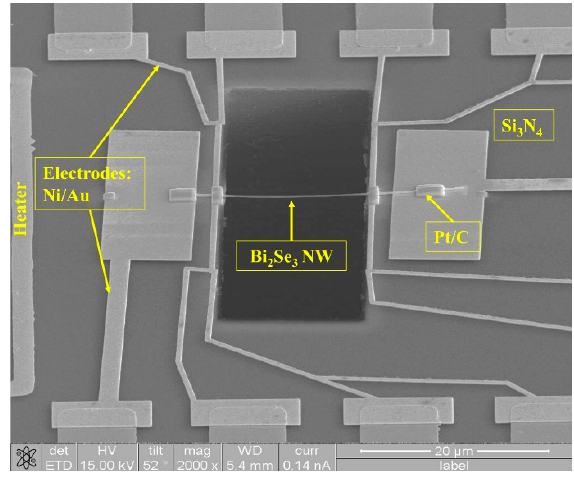
Figure 2. SEM images of a single-crystal Bi 2 Se 3 NW (diameter = 200 nm) placed on a Si 3 N 4 micro- Figure 2. The SEM image of a single-crystal Bi 2 Se 3 NW (diameter = 200 nm) placed on a Si 3 N 4 chip following electrode formation by using a FIB. microchip following electrode formation by using a